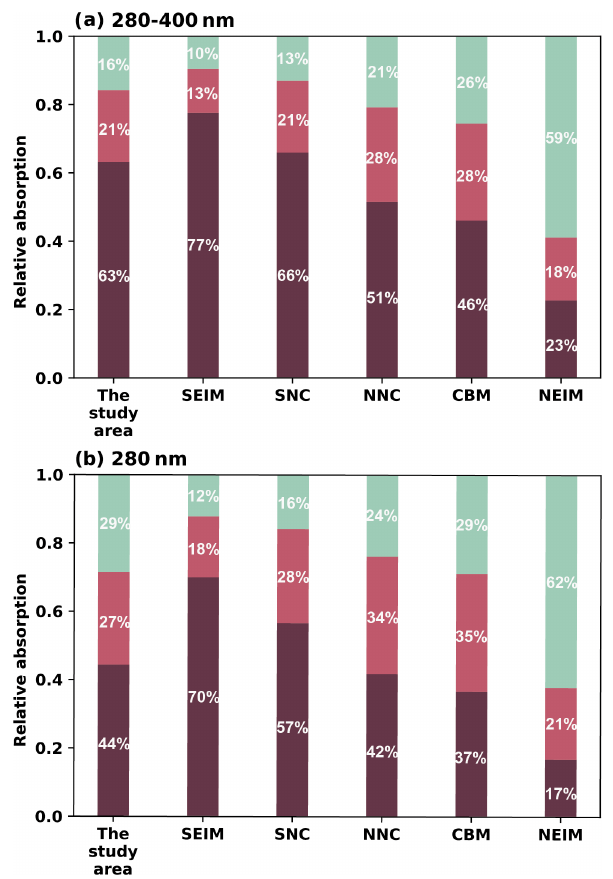
Figure 7. Regional averages for the relative contributions of the three fluorescent components to light absorption at wavelengths of (a) 280–400nm and (b)